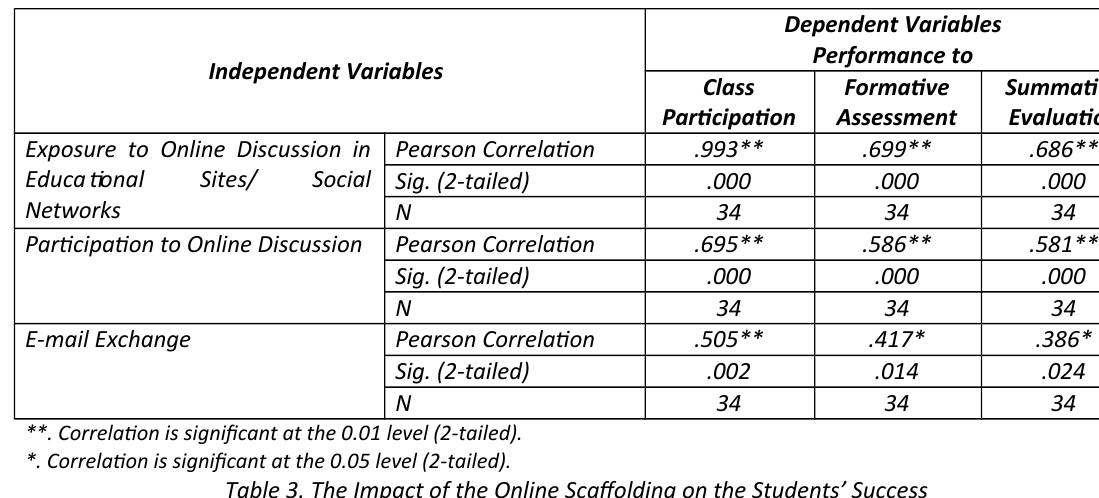
Table 3. The Impact of the Online Scaffolding on the Students’ Success in Achieving the Course’ Learning